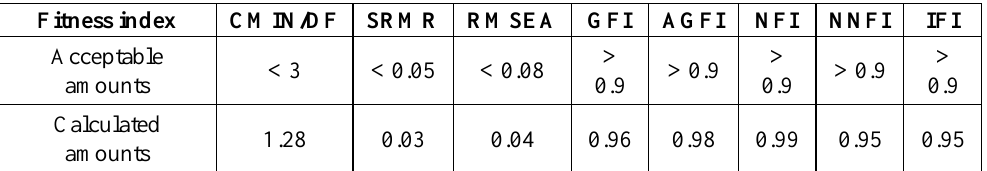
Table (4) Model goodness fit indices of decision making roles over auditors errors